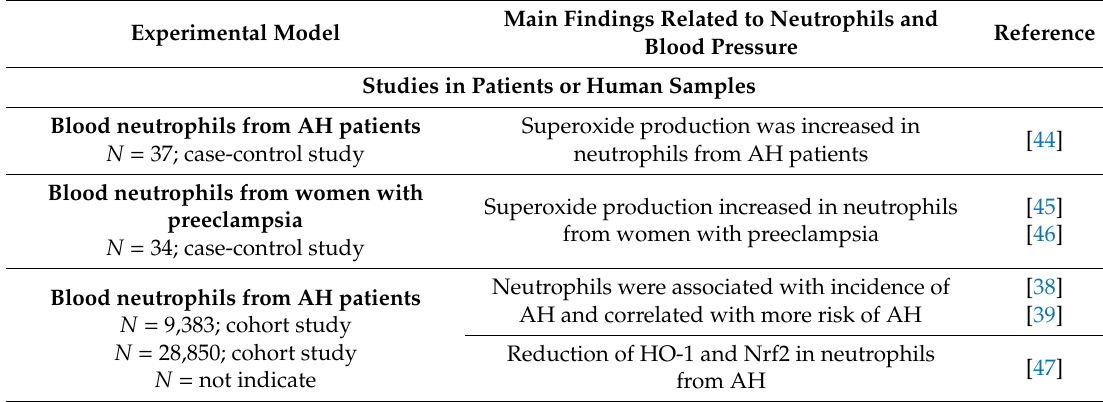
Table 1. Studies in patients and experimental animals, involving neutrophils in blood